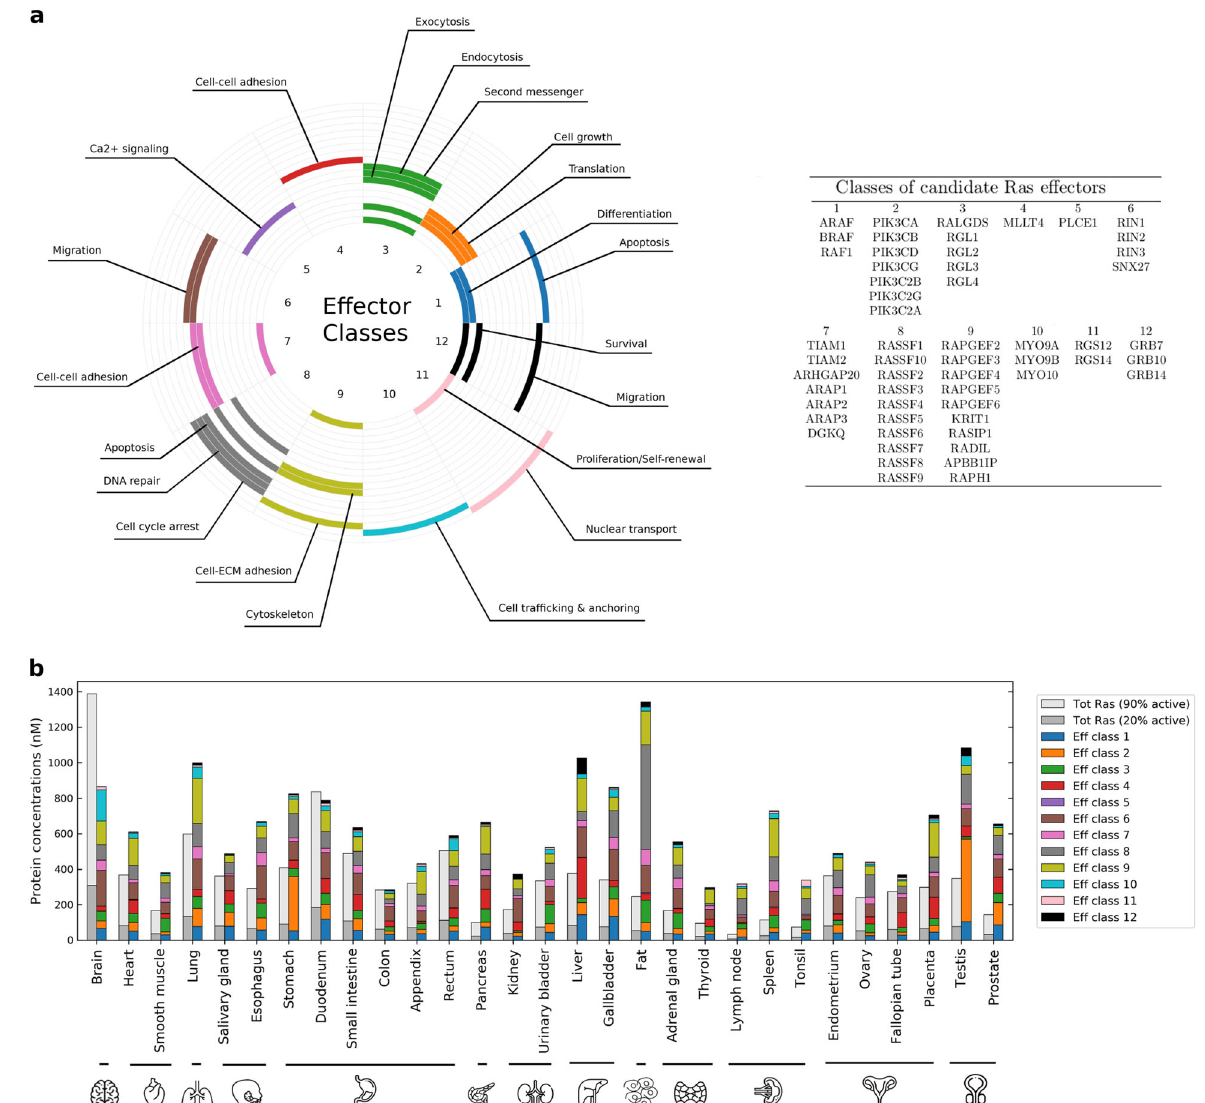
Fig. 1 The Ras-effector signaling system and protein abundances in 29 human tissues. a Table of effectors and their categorization into 12 classes, to which are associated different signaling pathways and cellular responses. b Bar plot comparing the level of Ras proteins (for 20% or 90% GTP load, in gray) against the level of Ras effectors (class-speci fi c abundance colored as per the legend). Concentrations of active Ras (H-, K-, and NRAS summed up together) in any of the 29 tissues are generally larger than the concentrations of all the effectors, thus satisfying the condition of competitive binding. Only exceptions are in brain and duodenum, although limited to the case where all Ras proteins are GTP loaded (90%